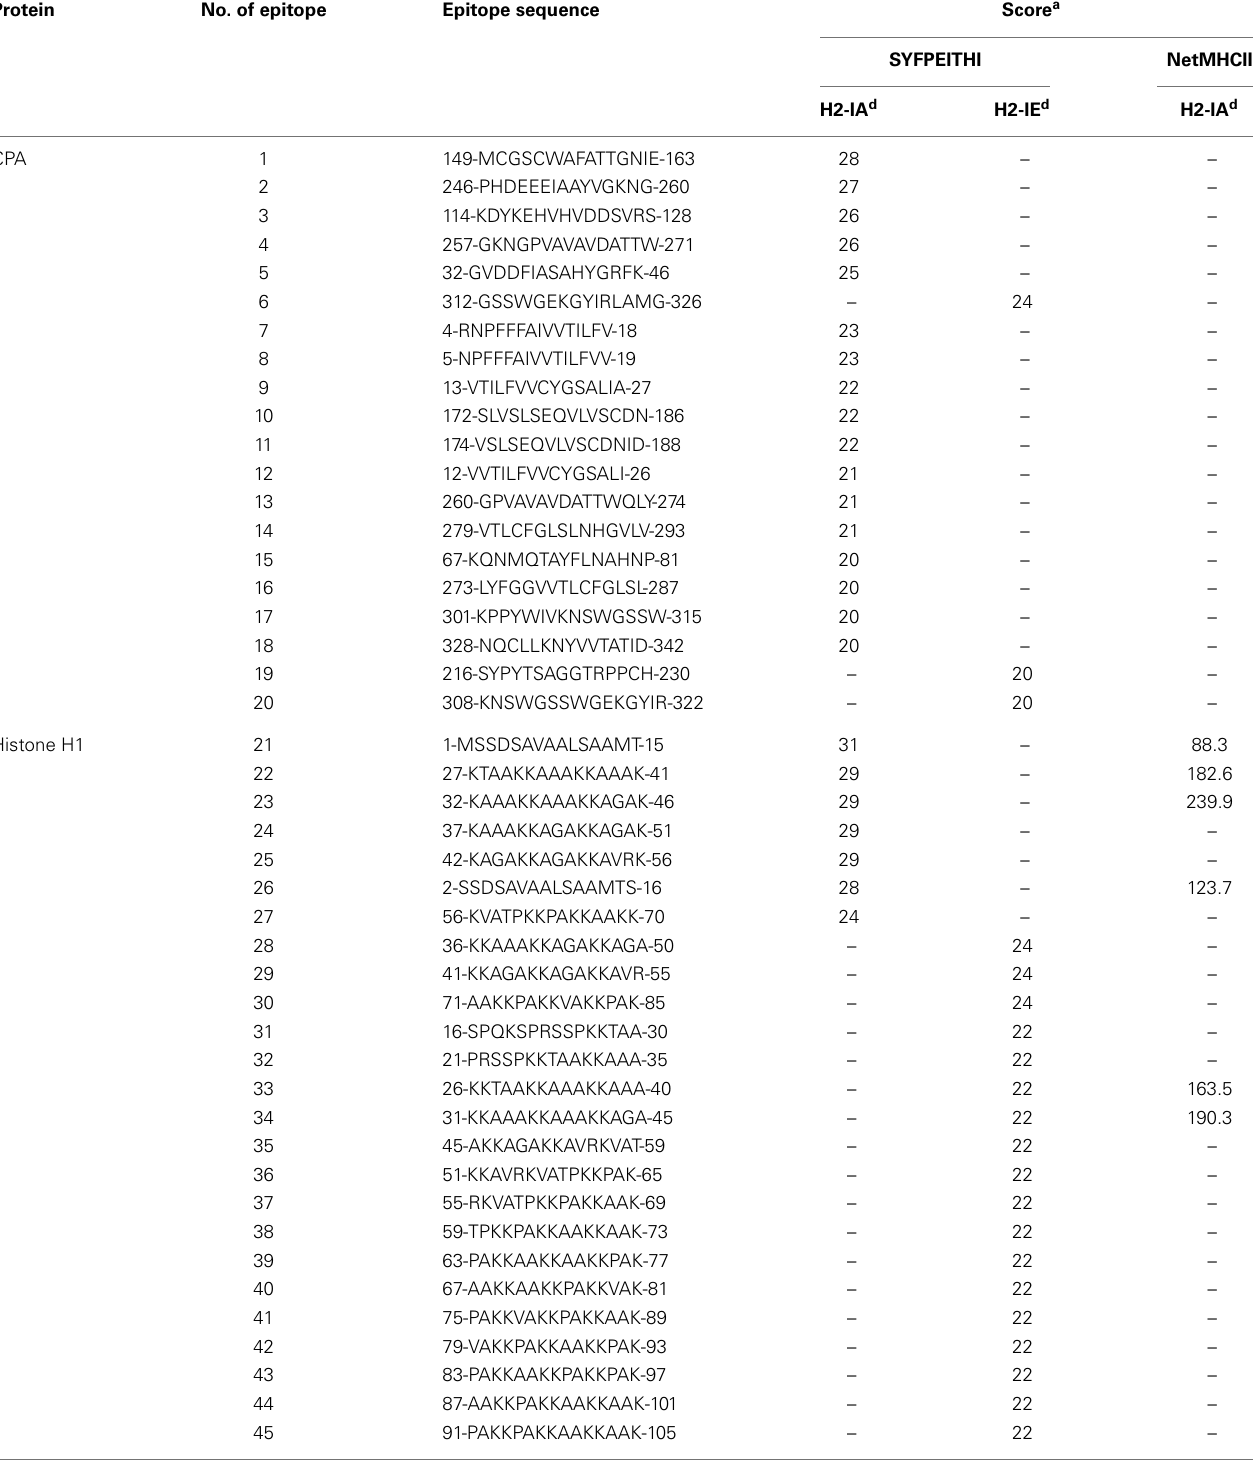
Table 3 | In silico predicted MHC class II-restricted 15-mer epitopes of L. infantum proteins . Protein No. of